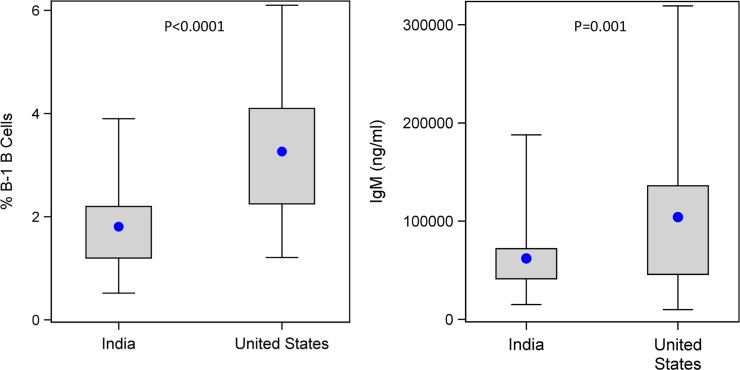
Differences in 'B-1' B cells and IgM between Indian and U.S. cohorts.B-1-like B cell percentages are shown in the left panel, with the blue dot indicating the mean, and whiskers extending from minimum to maximum values of observed data. B-1-like cells were gated as CD45+CD20+CD27+CD43+ and expressed as a percentage of total B cells (CD45+CD20+). IgM levels are shown in the right panel, as measured by Luminex assay, and expressed as ng/ml.